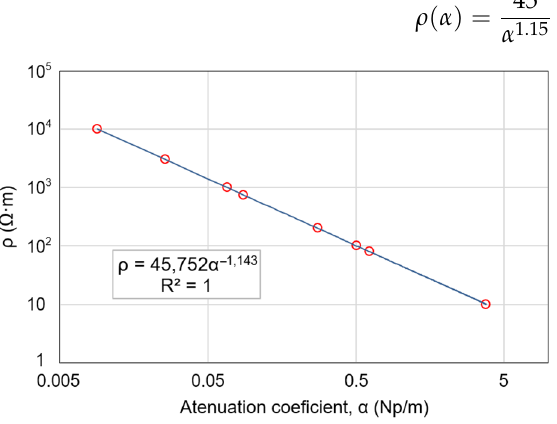
Figure 13. Resistivity values and attenuation coefficient, and least squares approximation